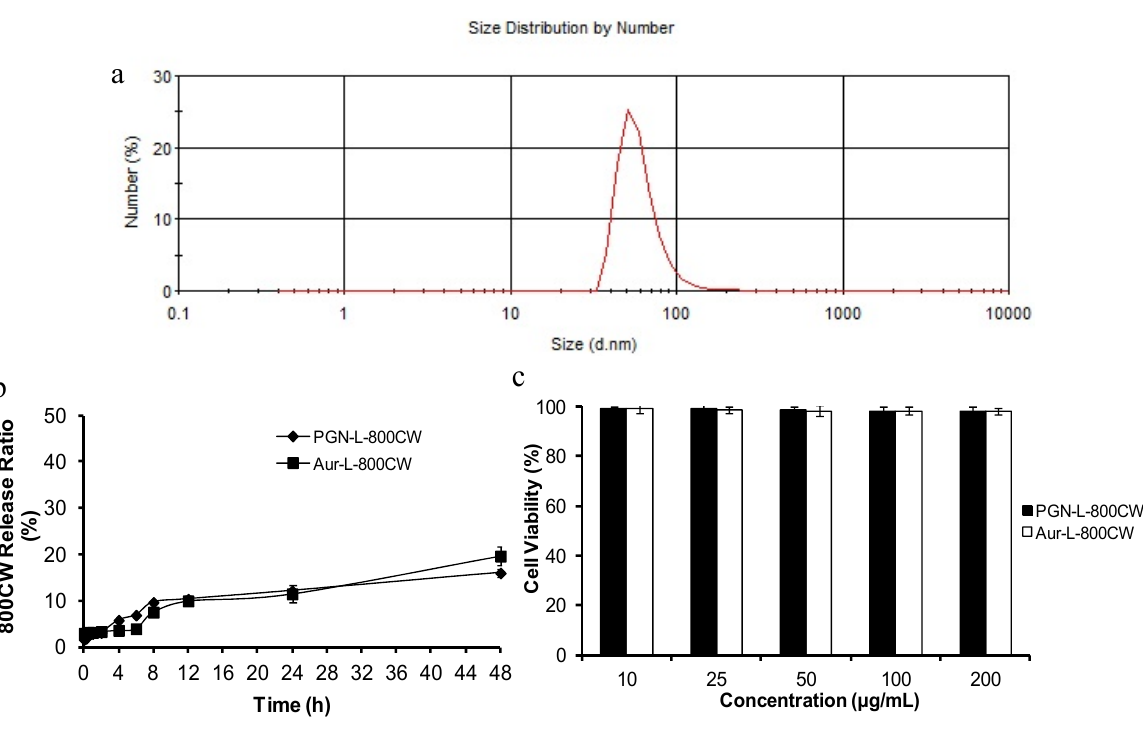
Figure 1. Characterization of the liposomal nanoprobes. ( a ) A size distribution curve obtained by dynamic light scattering (DLS) analysis indicates an average hydrodynamic size of PGN-L-800CW = 65 nm; ( b ) Release rates of 800CW from liposomes in PBS containing 10% serum oscillated with a shaker at a rate of 100 times per minute at 37 °C. Release rate of 800CW was negligible. c. Minimal cytotoxicity of ABAE endothelial cells was observed by trypan blue staining after incubation with the liposomal